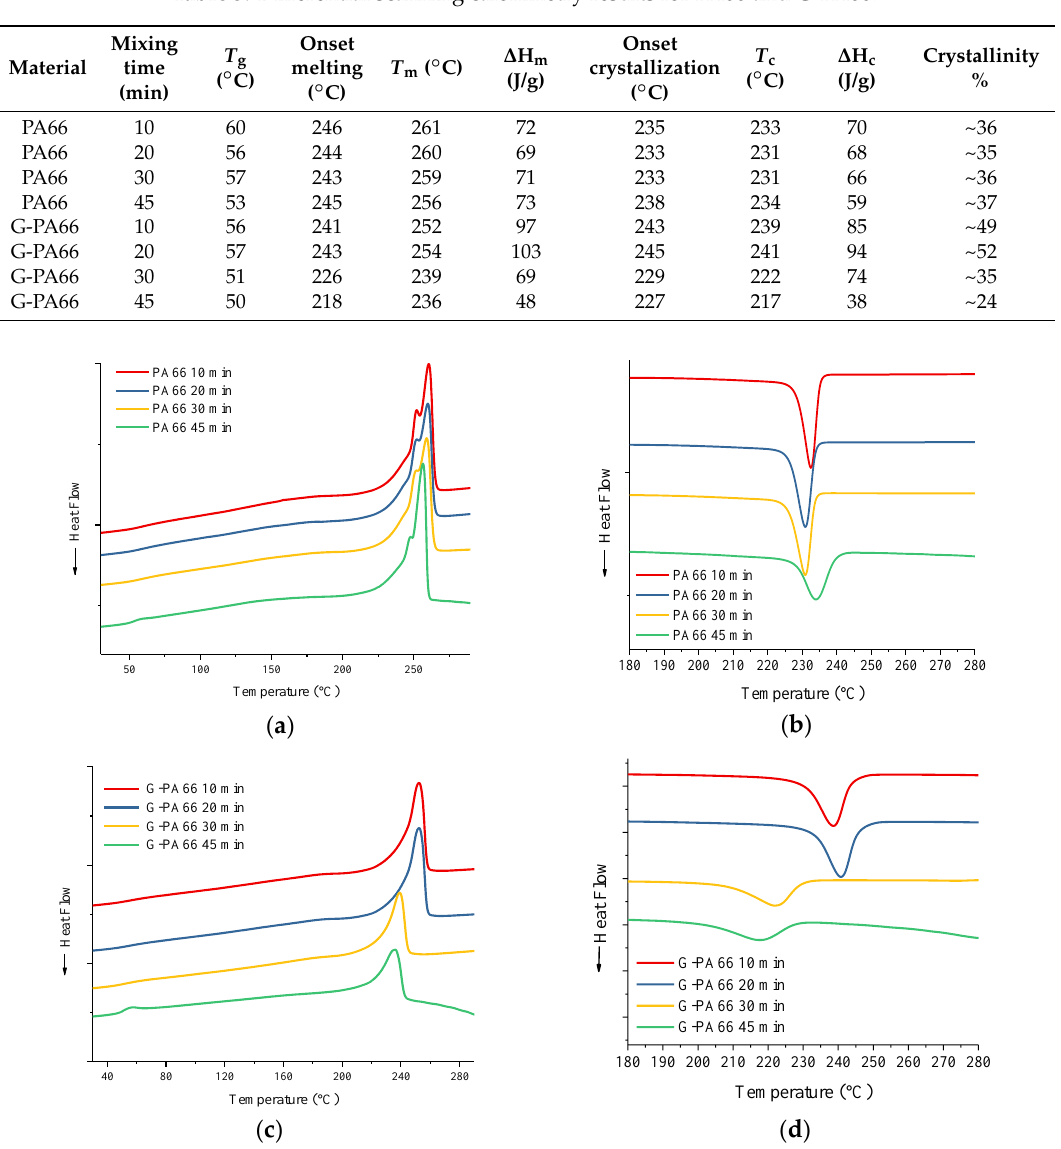
Table 3. Differential scanning calorimetry results for PA66 and G-PA66.